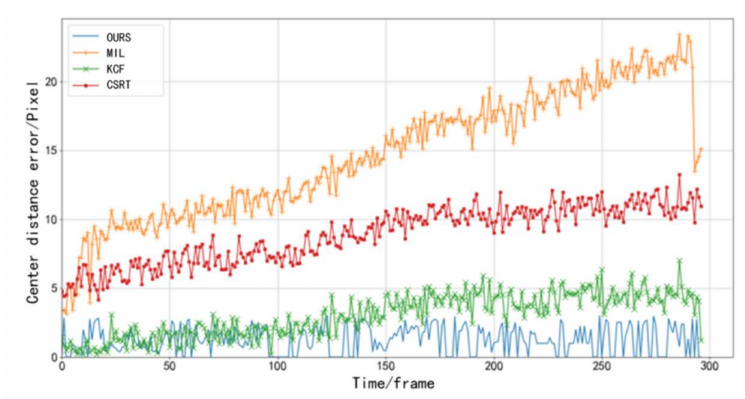
Figure 8. Error comparison of the four vehicle trajectory extraction algorithms.